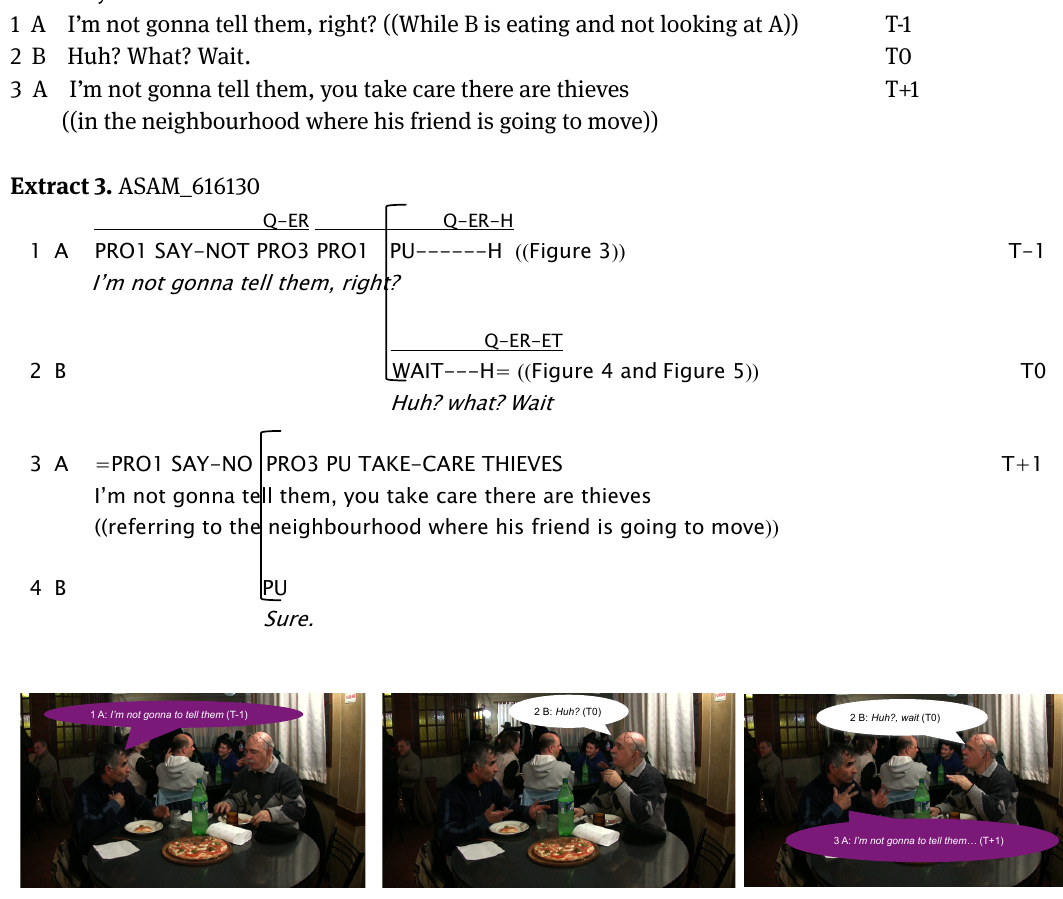
Figure 3. ‘I’m not gonna tell them, right?’ , Person A (left) asks Person B (right), while B is eating and not looking at A in line 1.